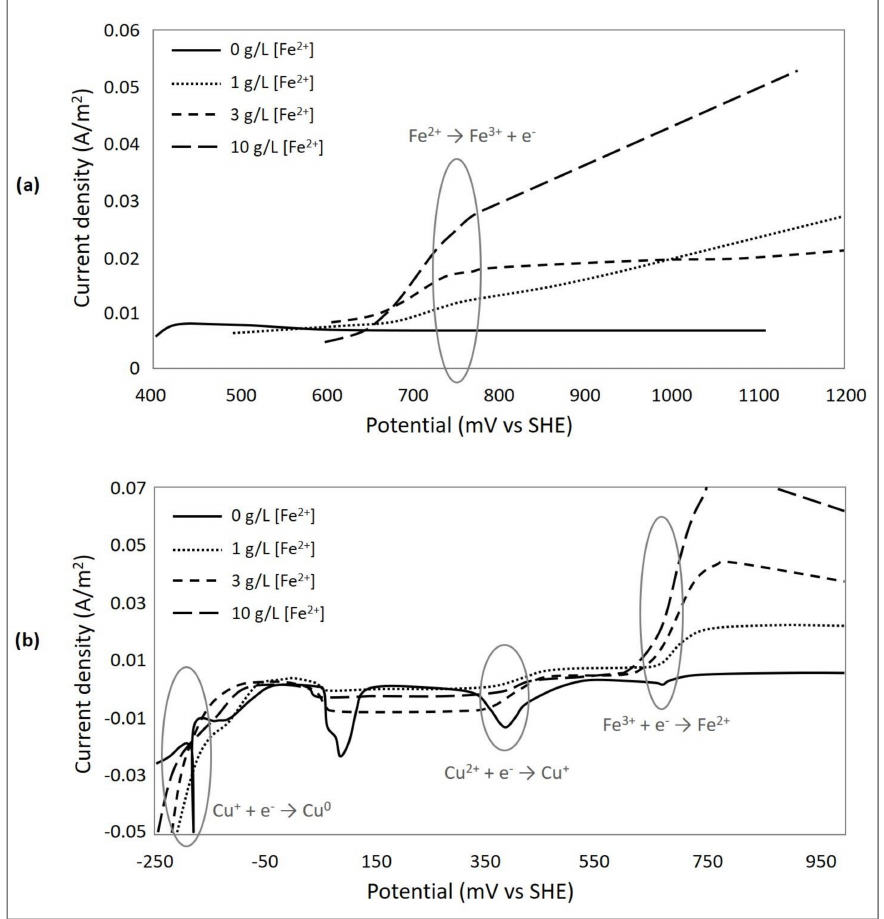
Figure 7. Effect of the concentration of ferrous ions at 0, 1, 5, and 10 g/L in the solution using an inert platinum electrode (1 mV/s) ( a ) Anodic sweep, ( b ) cathodic sweep. The solution contains 20 g/L [Cl − ], 0.5 g/L [Cu 2+ ], and pH 1 adjusted with sulphuric acid at 25 ◦